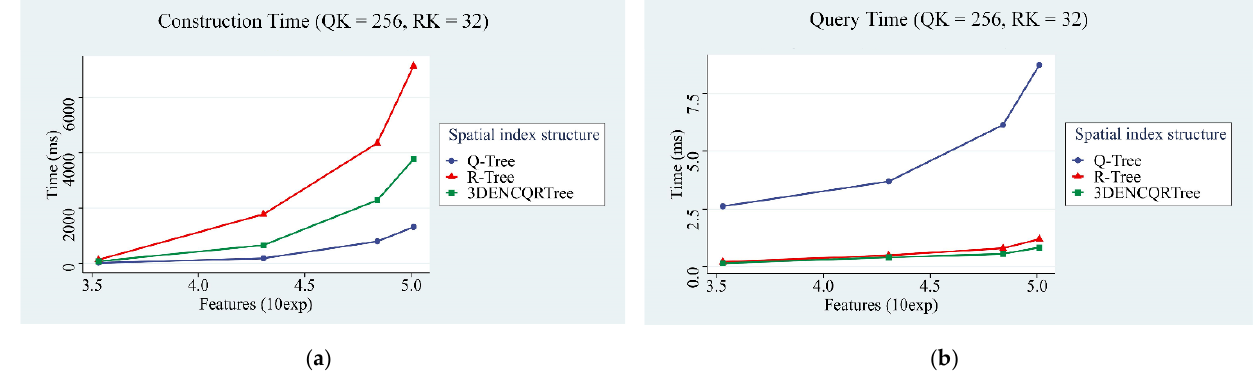
Figure 11. Relationships between construction and query time of 3DENCQR-tree and different thresholds. ( a , c , e , g )Relationships between the construction of 3DENCQR-tree and different QK thresholds in RK = 16, RK = 32, RK = 64 and RK = 128; ( b , d , f , h ) Relationships between the query of